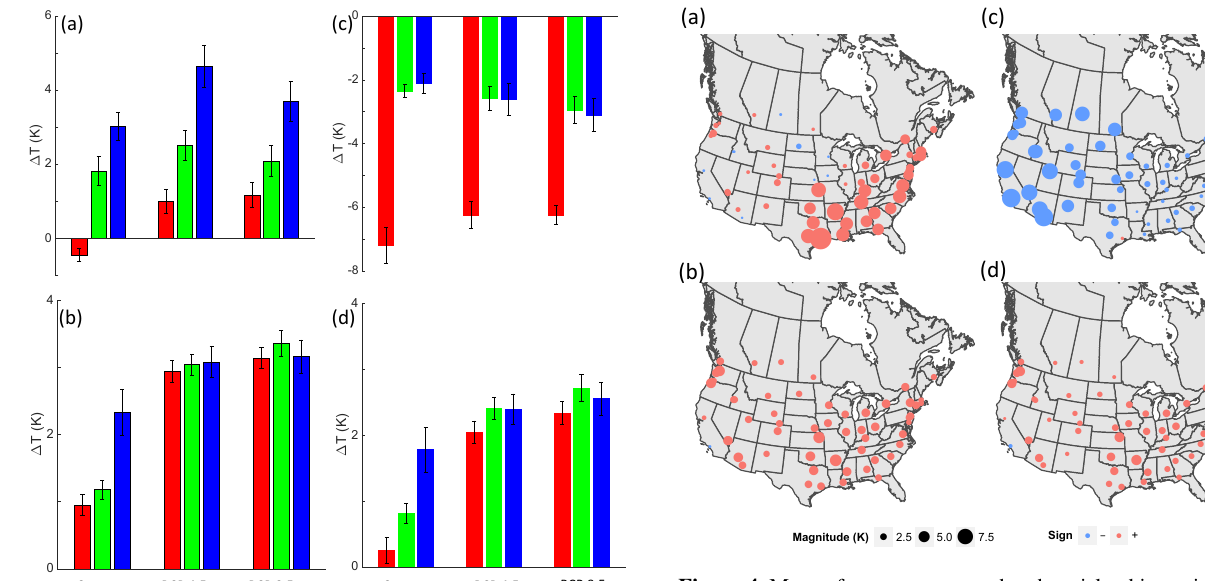
Figure 4. Maps of summer mean urban heat island intensity during 2071–2100 under the RCP4.5 scenario. (a) daytime control (CTR) simulation; (b) nighttime CTR simulation; (c) daytime white roof (WHT) simulation; (d) nighttime WHT simulation. Red and blue symbols denote positive and negative UHIs,